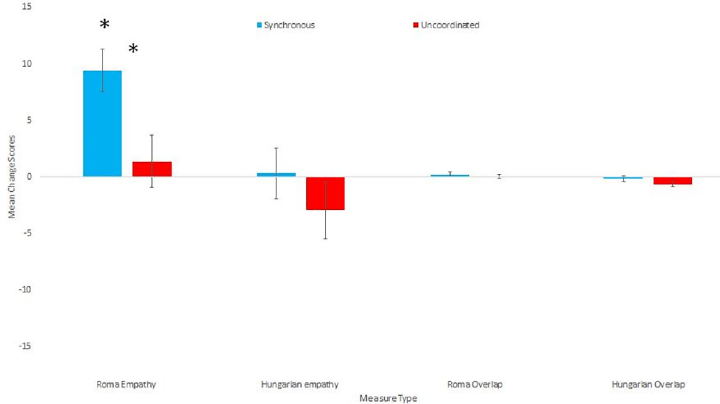
Fig 2. Means and standard errors for the Overlap and Empathy change scores towards Hungarians and Roma.